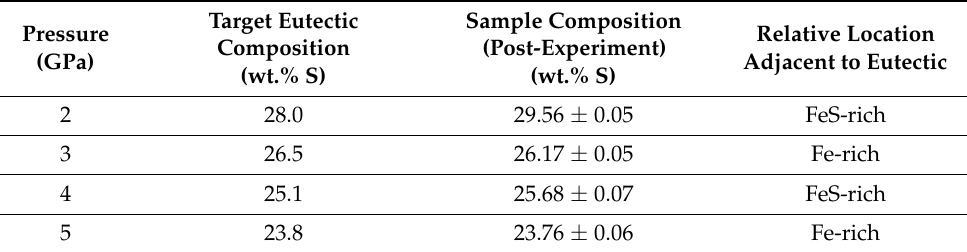
Table 1. Values of targeted eutectic Fe-FeS sample compositions and post-experiment analysis results of sample compositions for each pressure in this study. Post-experiment sample compositions are noted to be either Fe-rich or FeS-rich relative to the target pressure-dependent eutectic composition. Target Pressure